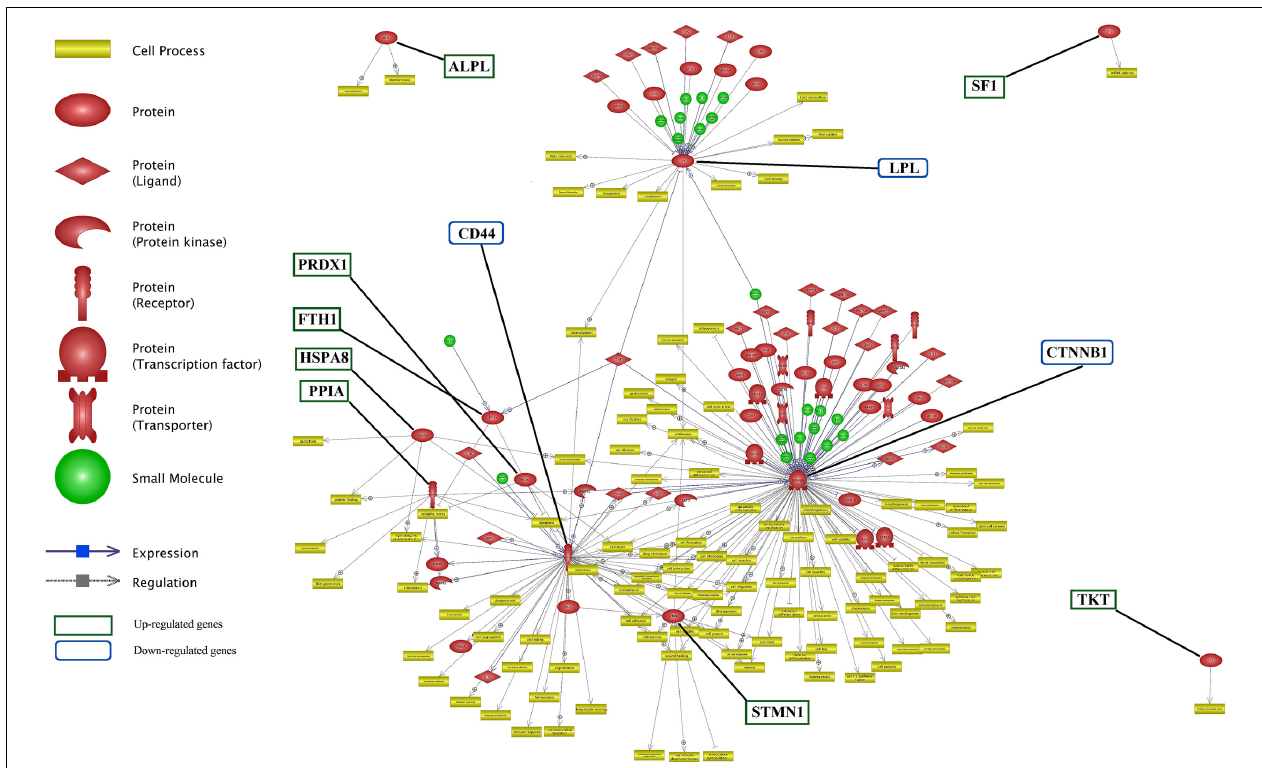
FIGURE 5 | Network for differentially expressed genes involved in lactation process. The green and blue boxes are up- and down-regulated genes interactions, respectively. CTNNB1, CD44, STMN1 , and LPL genes from down-regulated genes list and TKT, SF1 , and ALPL from up-regulated genes list have the most number of